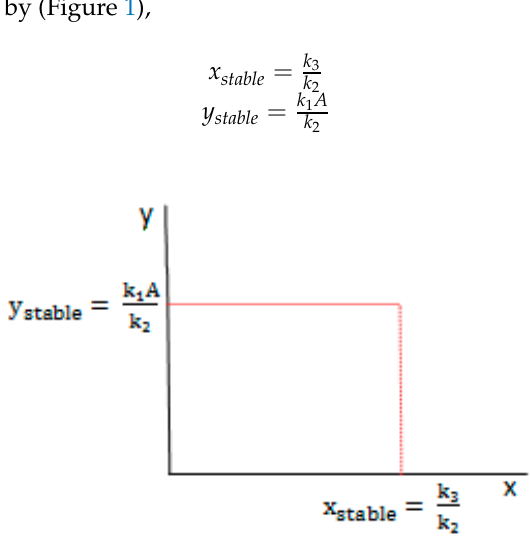
Figure 1. Equilibrium point in the phase diagram.